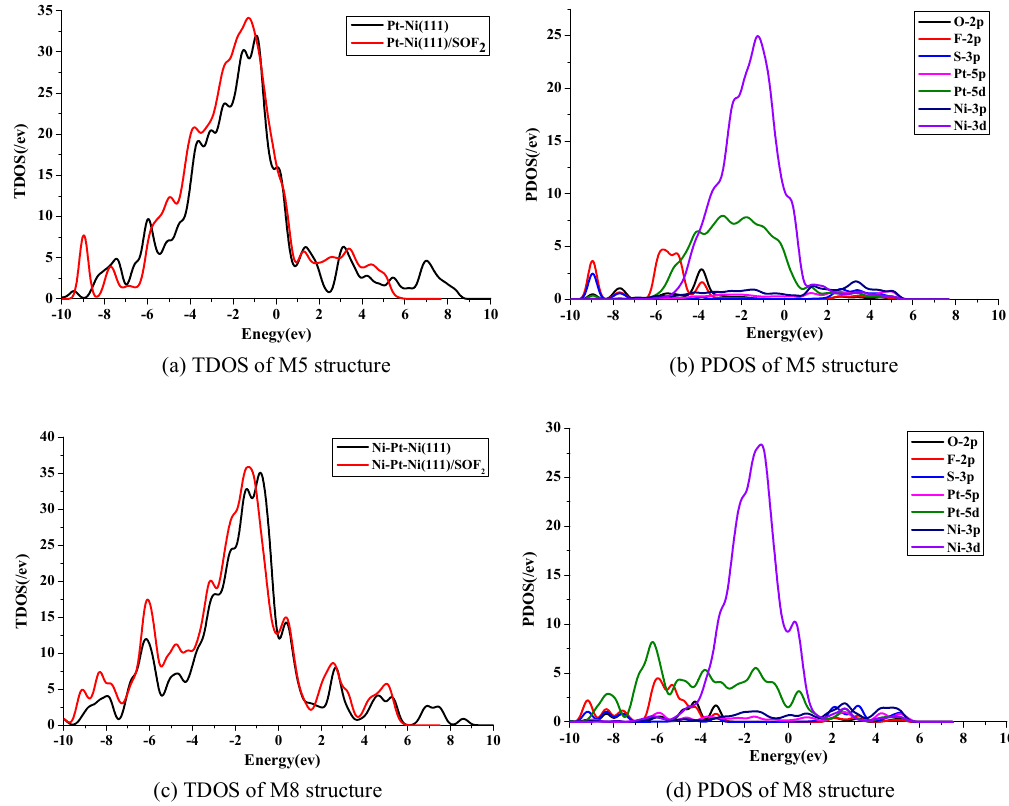
Figure 6. TDOS and PDOS distribution of M5 and M8: ( a ) TDOS of M5 structure, ( b ) PDOS of M5 structure, ( c ) TDOS of M8 structure, ( d ) PDOS of M8 structure.